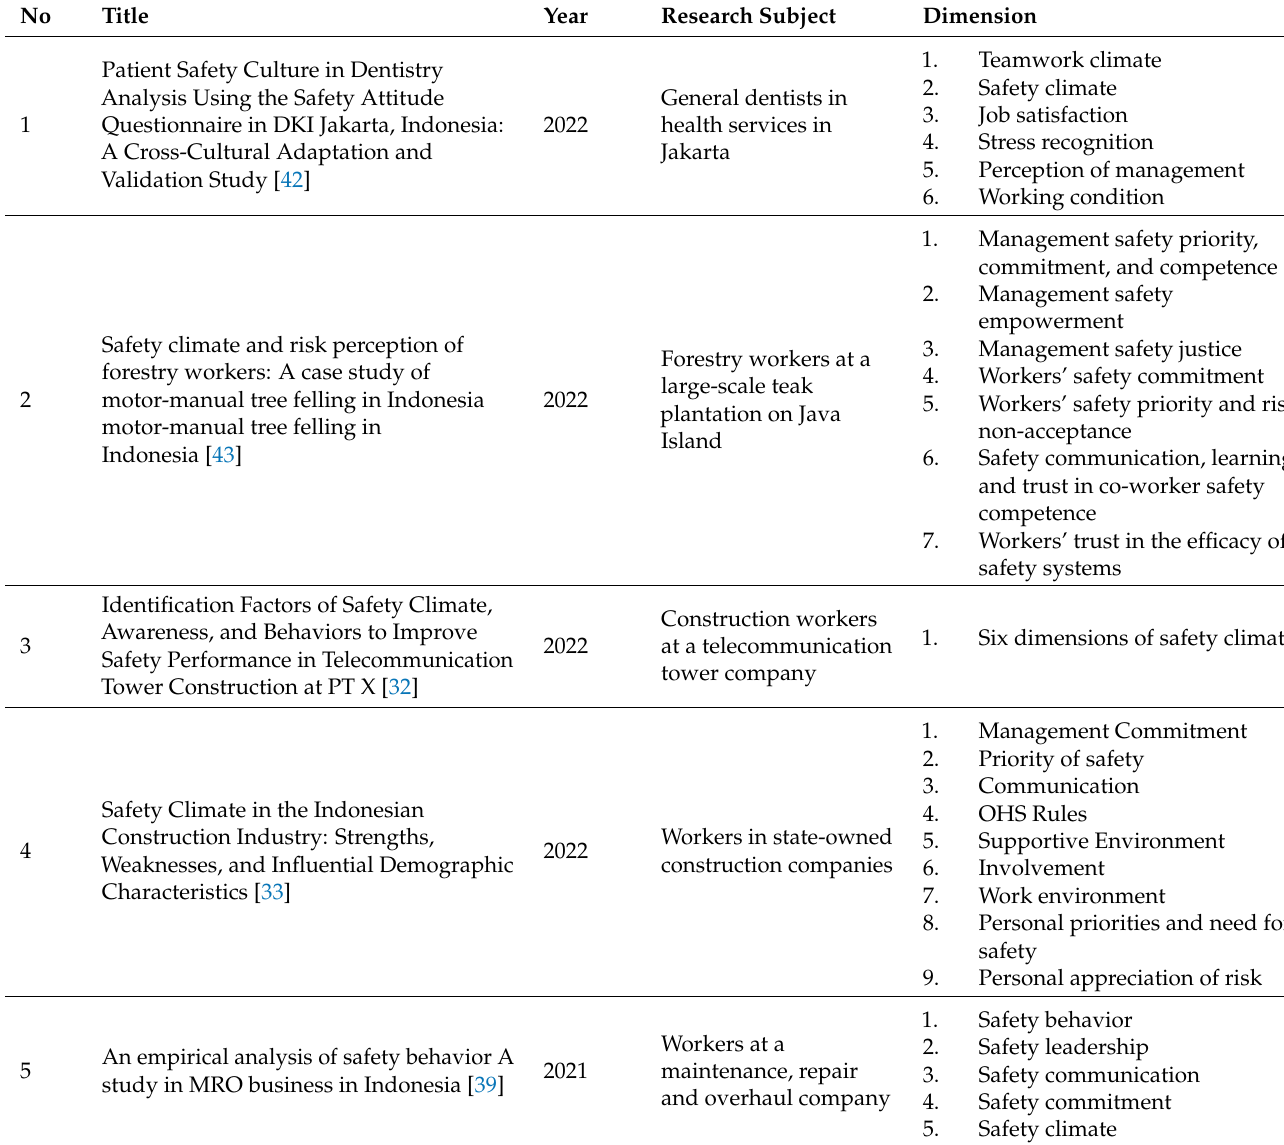
Table A1. List of research articles on safety climate in